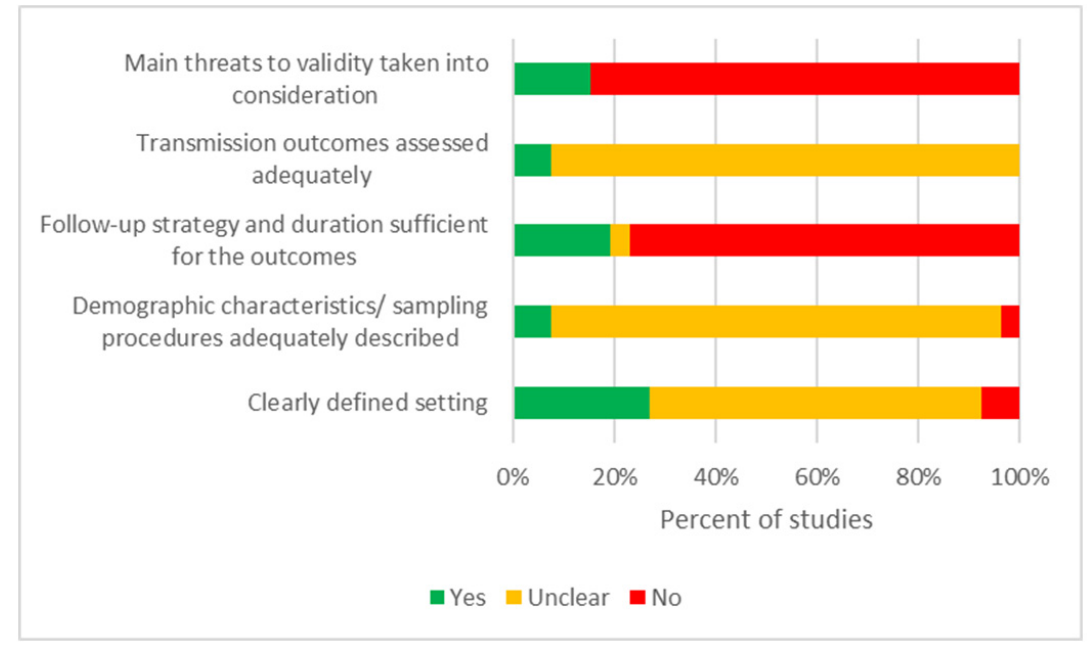
Figure 1. Risk of bias graph in studies on onboard transmission of SARS ‐ CoV ‐ 2.